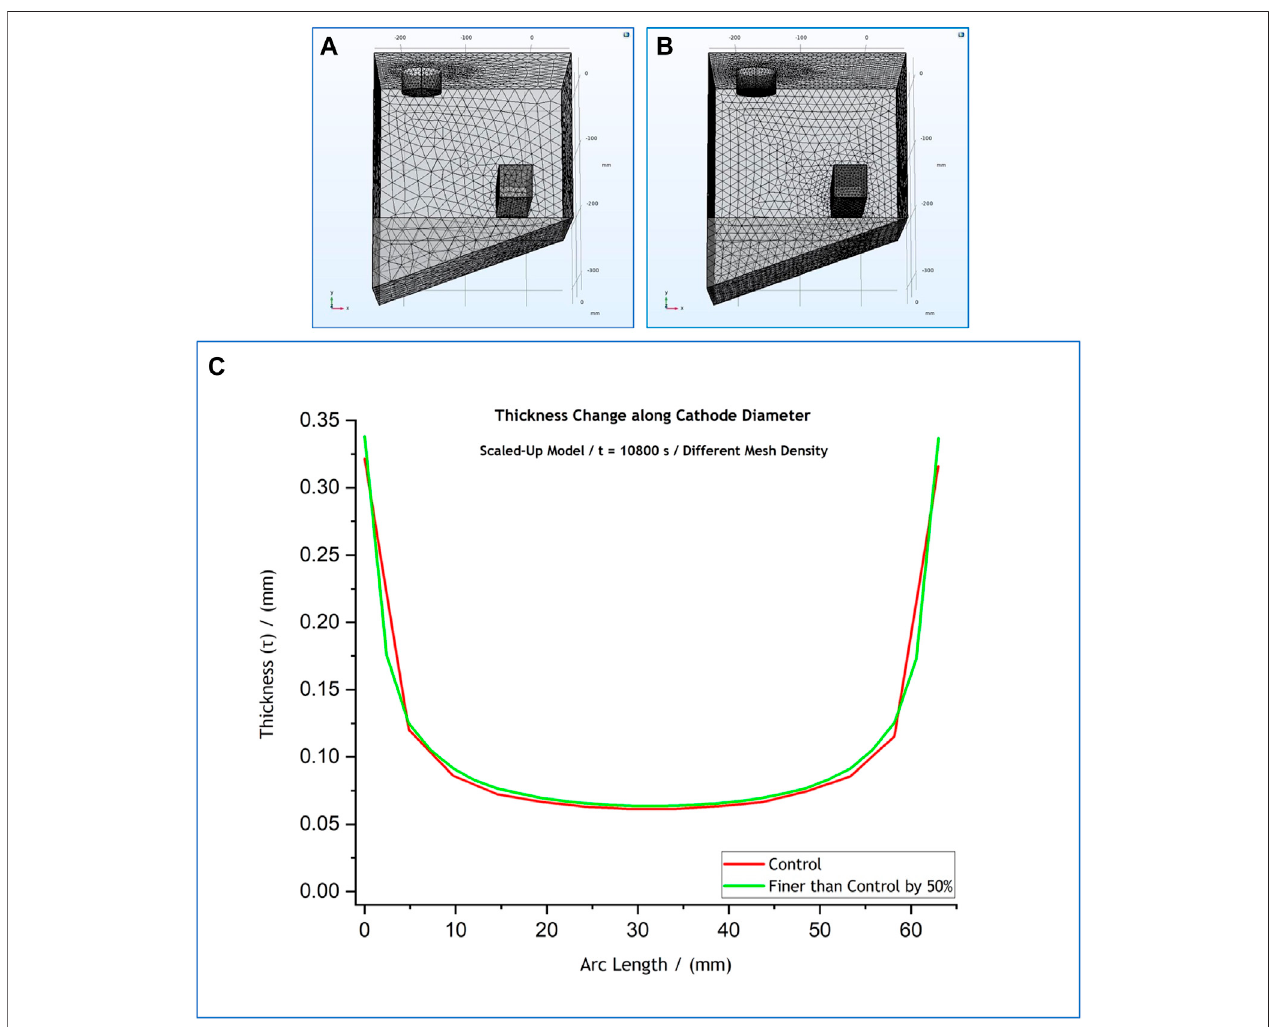
FIGURE 6| (A) Control mesh density (red), (B) mesh spacing fi ner than the control by50% (green).Figure (C) shows an overlap of the thickness pro fi les predicted by the scaled up model for the different mesh densities. The results simulate a 3-h process at 50 ℃ .